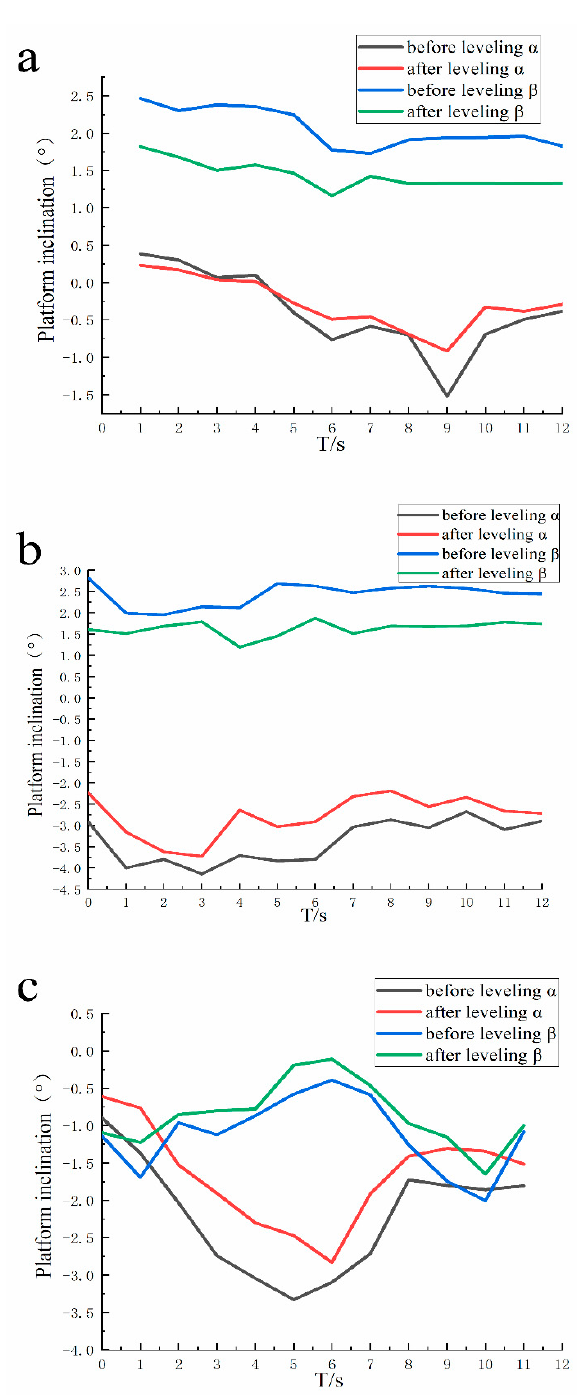
Figure 13. Dynamic automatic levelling results.